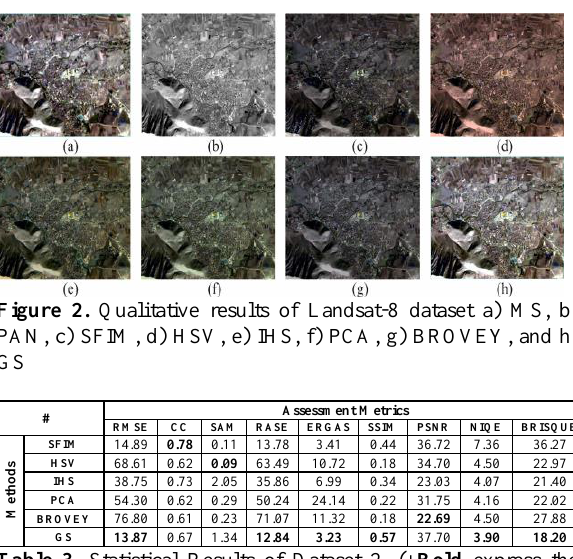
Table 3. Statistical Results of Dataset 2. (+ Bold express the most successful result.)